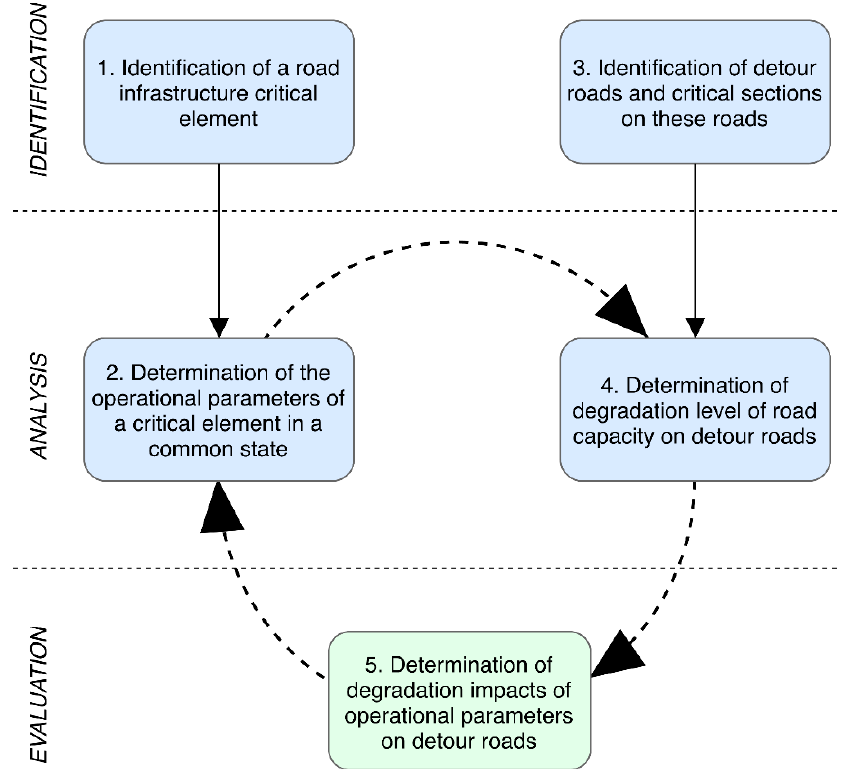
Figure 7. Algorithm of a road transport impact dynamic modeling system.